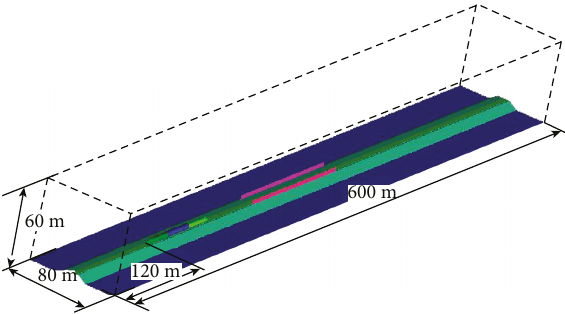
Figure 4: Computation domains of a high-speed train passing the embankment air barriers.